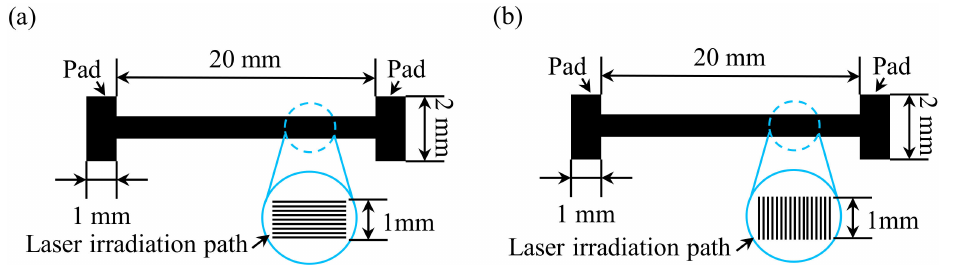
Figure 4. Laser scanning patterns. ( a ) Parallel and ( b ) vertical